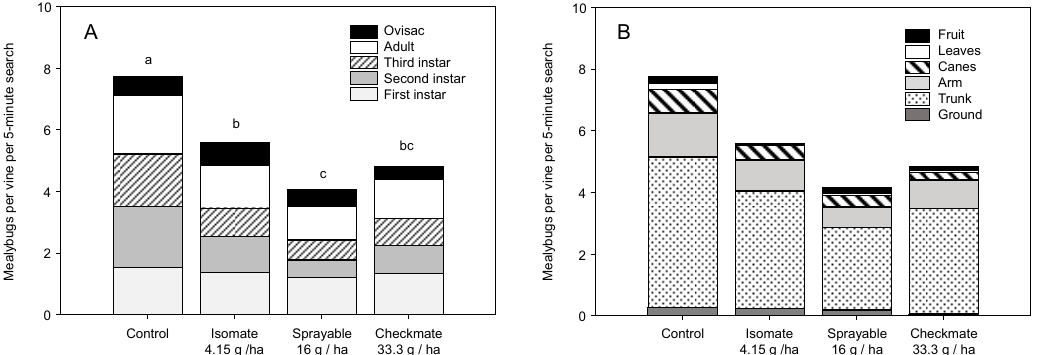
Figure 5. 2004 field studies of five minute per vine searches for Pl. ficus in plots treated with no mating disruption (MD), Isomate (4.15 g/ha and 8.3 g/ha), CheckMate Flowable (32 g/ha), or CheckMate dispensers (33.3 g/ha) showing ( A ) season-long average Pl. ficus by developmental stage category and ( B ) Pl. ficus by location on the vine. Different letters above each bar represent significant differences in the total number of mealybugs in each treatment, p < 0.05.